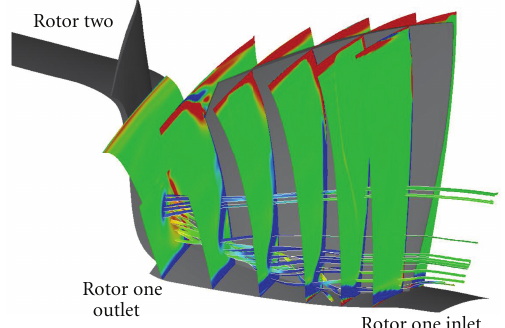
F 13: �rogression of a secondary �ow along the rotor one suction surface. Stream ribbons and cut plans colored by streamwise vorticity. Time mean solution. Red is positive, blue is negative.